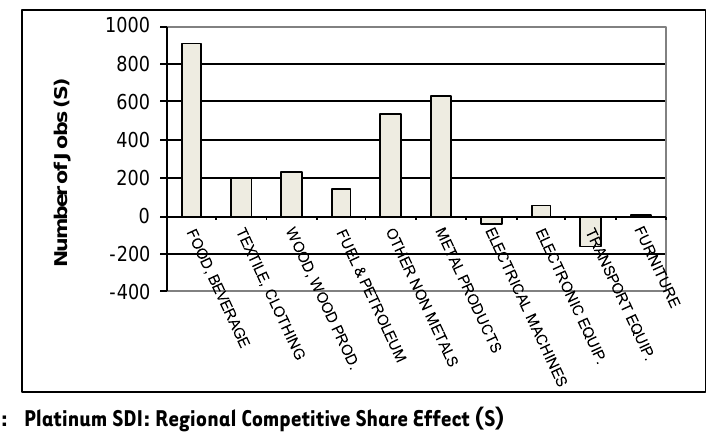
FIGURE 5: Platinum SDI: Regional Competitive Share Effect (S) Source: Rex Database, 2011 – Authors’